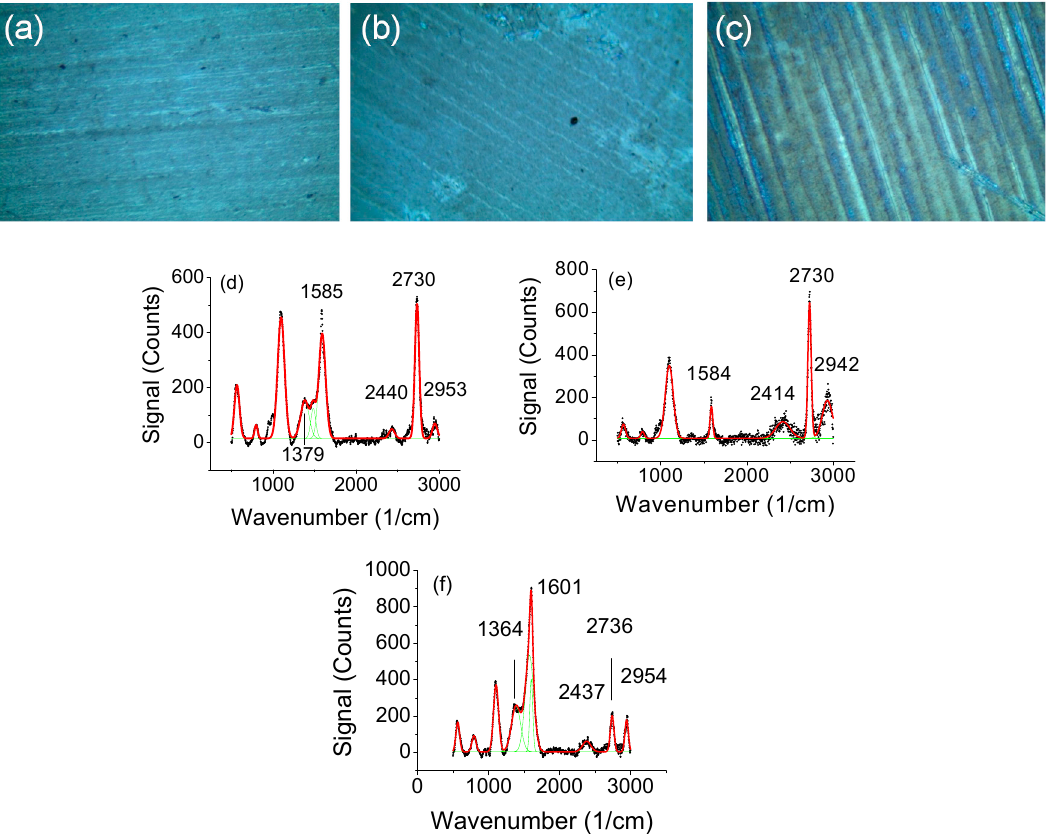
Figure 6. ( a ) 10-nm alumina-graphene on glass. ( b ) 10-nm hafnia-graphene on glass. ( c ) 10-nm alumina-graphene on glass transferred with an additional 50-nm thick PMMA layer. The microscope objective was x20. Raman spectra taken with 442 nm HeCd laser: ( d ) 10-nm thick alumina-graphene. ( e ) 10-nm thick hafnia-graphene. ( f ) 10-nm alumina graphene with an additional PMMA layer. In (d) and (f), the region between 1300-1650 1/cm is well-fitted with three peaks rather the expected two. The lines at 1100 1/cm and below are attributed to the glass slide (corroborated separately but not shown here).